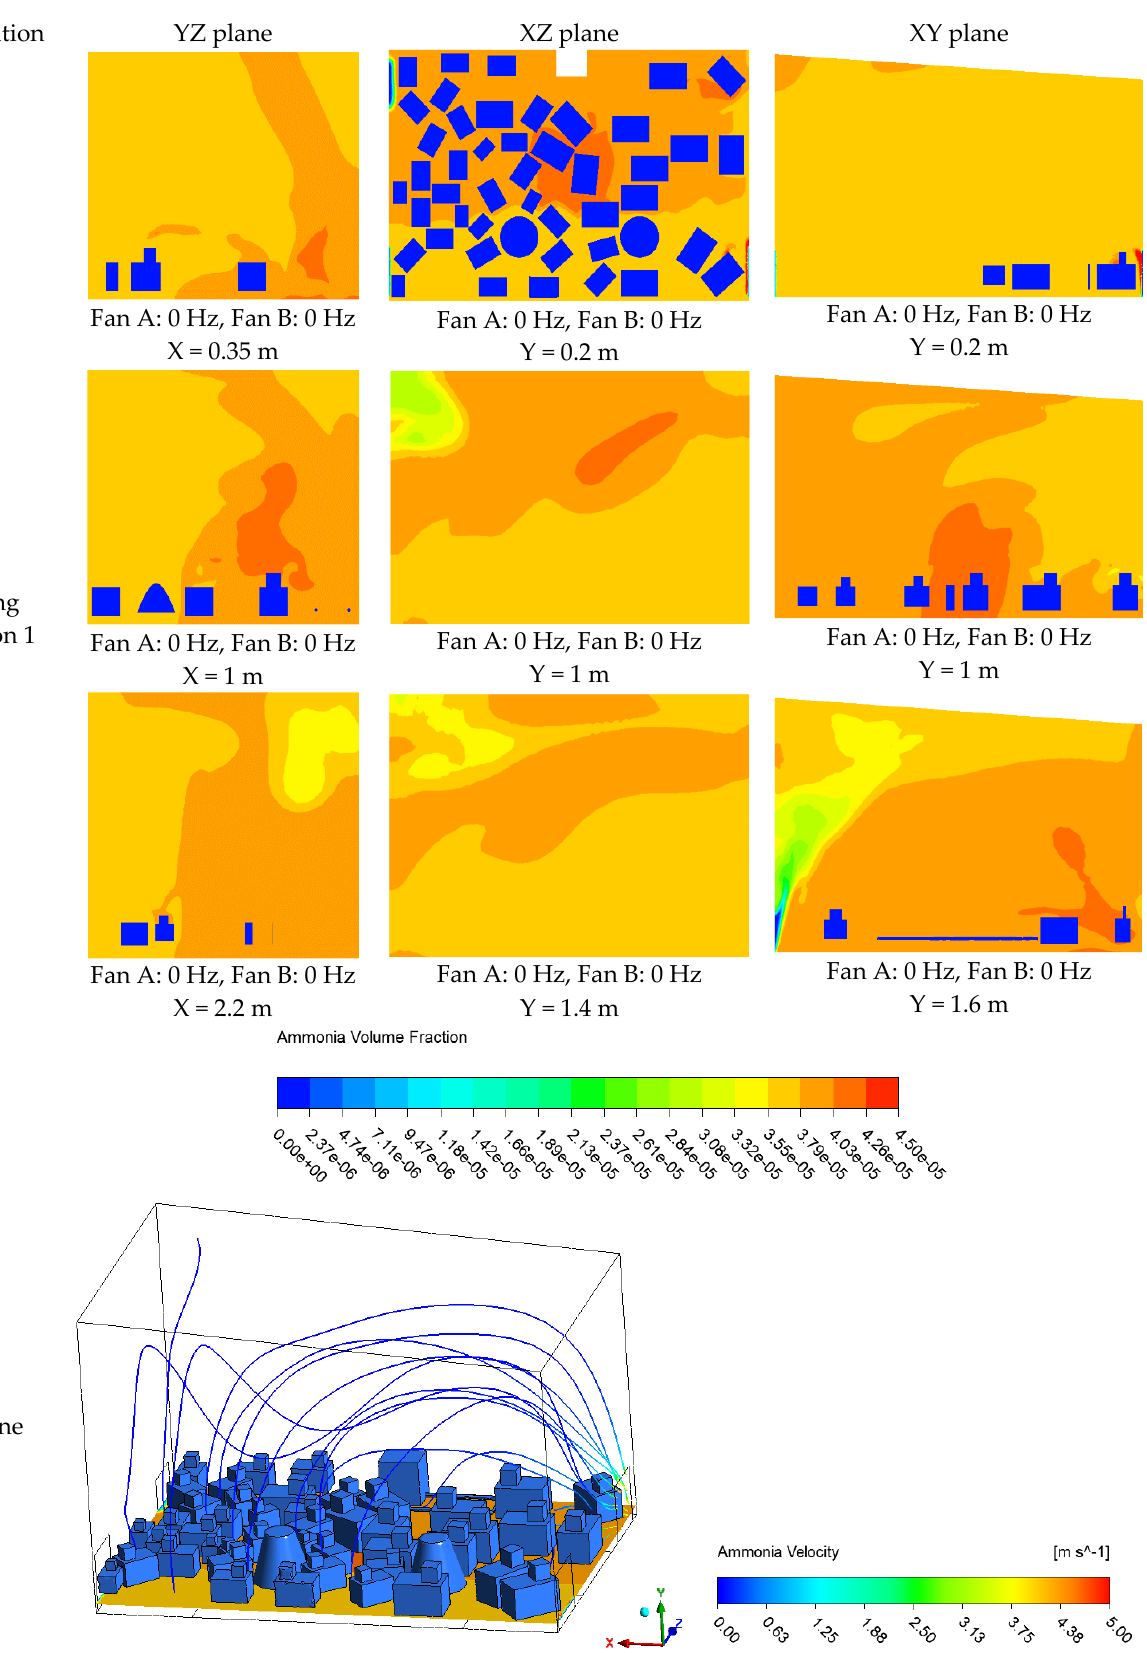
Figure 9. Simulation results of ammonia concentration distribution under working condition 1.